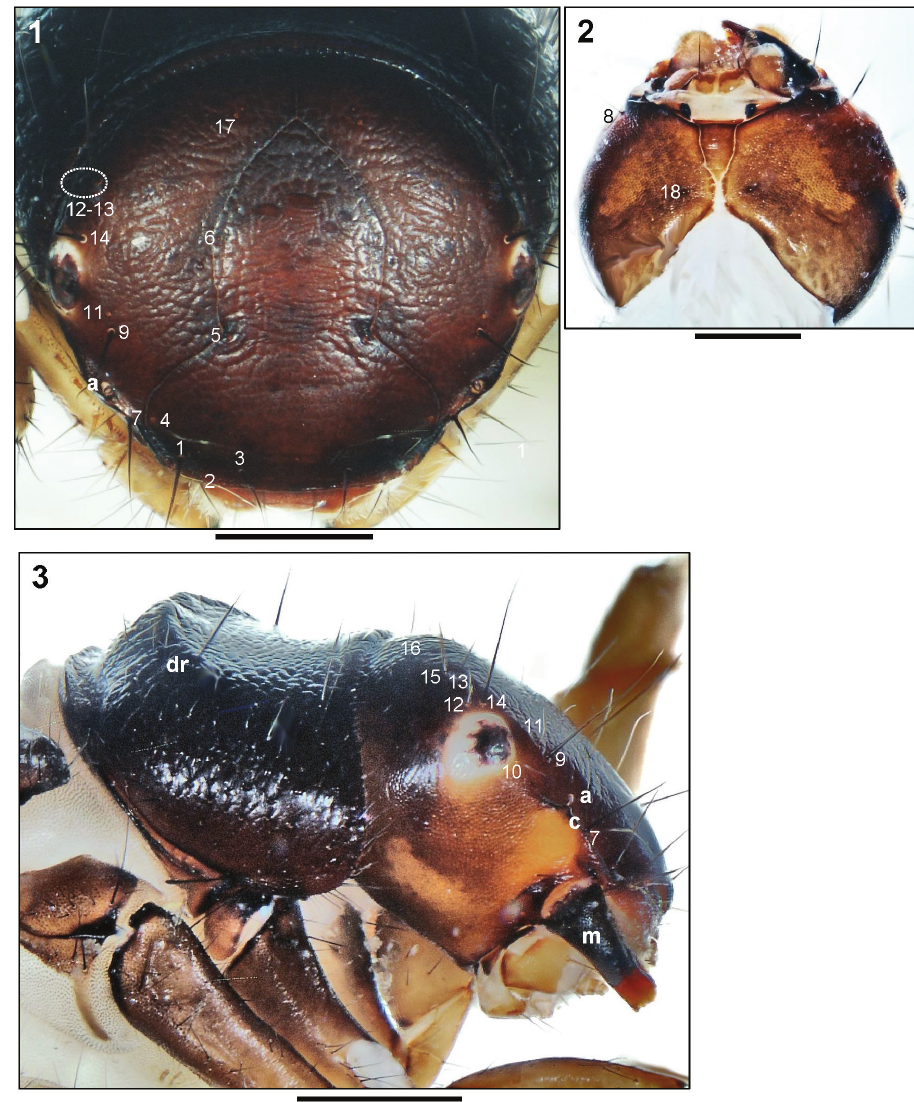
Figures 1–3. Drusus dudor Oláh, 2017, 5 th instar larva. 1 Head, dorsal view (a: antenna; numbers refer to setal positions) 2 Head, ventral view (numbers refer to setal positions) 3 Head and prothorax, right lateral view (a: antenna; c: lateral carina; dr: dorsal ridge; m: mandible; numbers refer to setal positions). Scale bars: 0.5